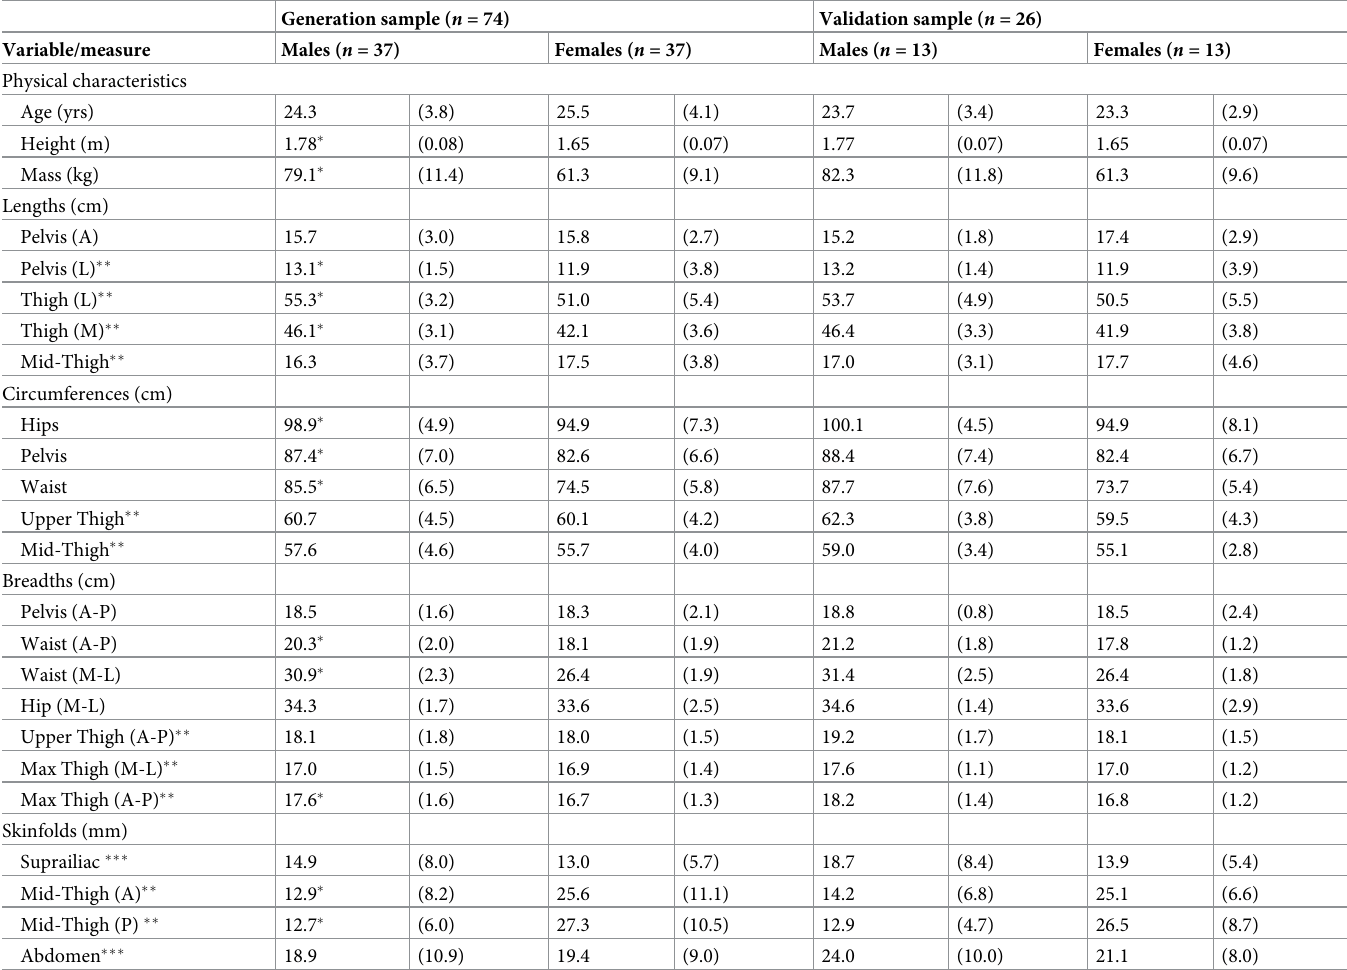
Table 1. Mean ( ± SD) general physical characteristics and anthropometric measures for young (16–35 years) male and female participants in both generation and validation